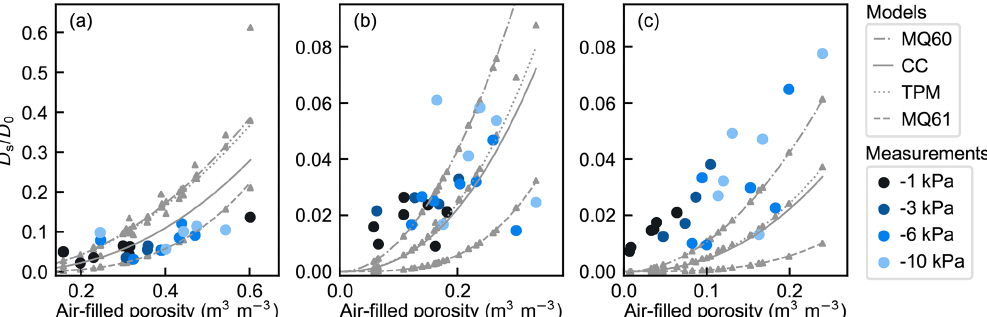
Figure 3. Measured (circular markers) and model-estimated (lines) relative diffusivity ( D s /D 0 ) against air-filled porosity for peat samples from the depths of (a) 0–5cm, (b) 20–25cm, and (c) 40–45cm. Individual values of models MQ60, MQ61, and TPM are presented by triangular gray markers, and corresponding reference lines obtained using average porosity values for each depth are also